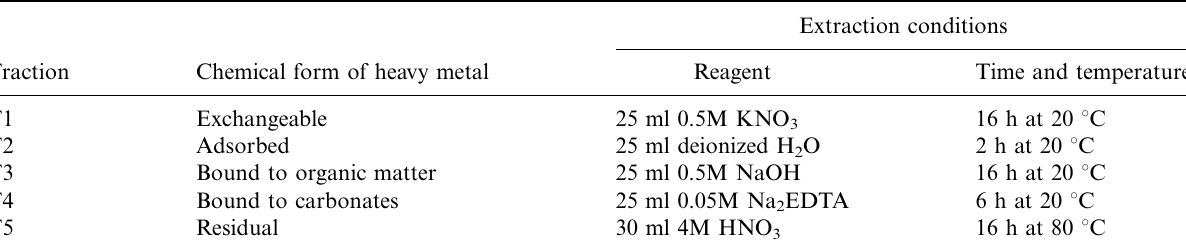
Table 1. Sequential extraction procedure according to Emmerich et al. (1982)